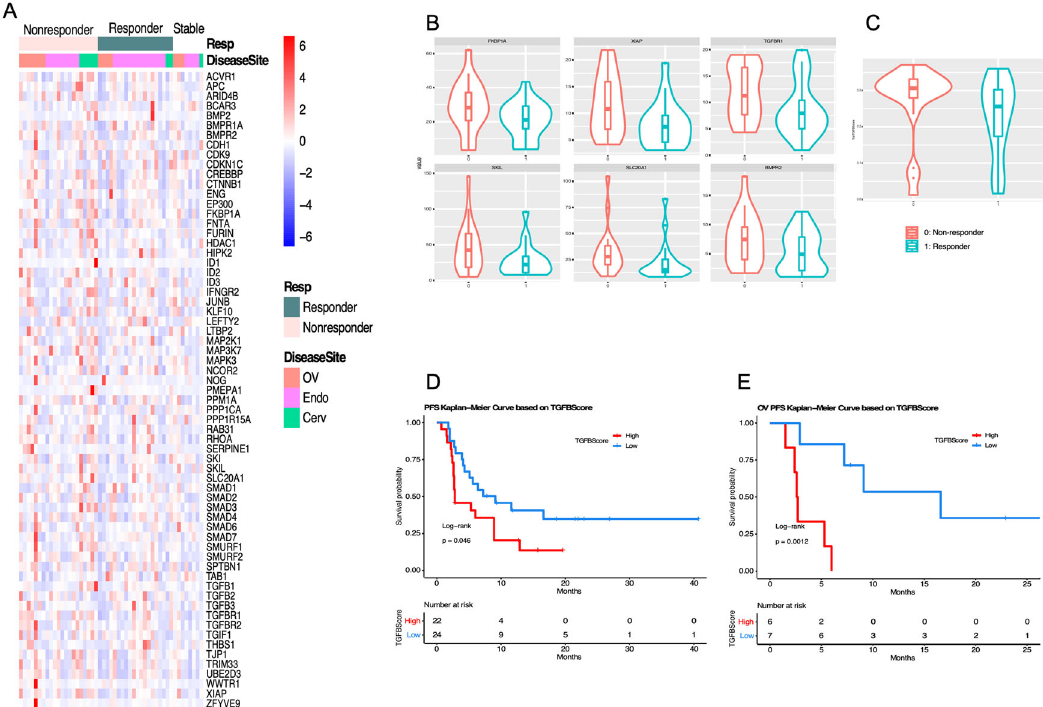
Fig. 3 TGF- β signaling pathway gene expression pro fi le and survival curve based on TGF- β score generated. A Heatmap of all 65 curated TGF- β pathway genes, sorted by responders and non-responders in each 3 disease types; B Violin plot of top 6 individual genes ( SLC20A1, XIAP, TGFBR1, BMPR2, FKBP1A , and SKIL ) expression in TGF- β pathway between responders and non-responders; C Violin plot of the TGF- β score generated using these 6 genes between responders and non-responders; D Kaplan – Meier curves of PFS based on TGF- β score in the entire cohort; E Kaplan – Meier curves of PFS based on TGF- β score in ovarian cancer patients. For panels D and E , the TGF- β score group “ High ” or “ low ” was de fi ned by the median expression of the TGF- β